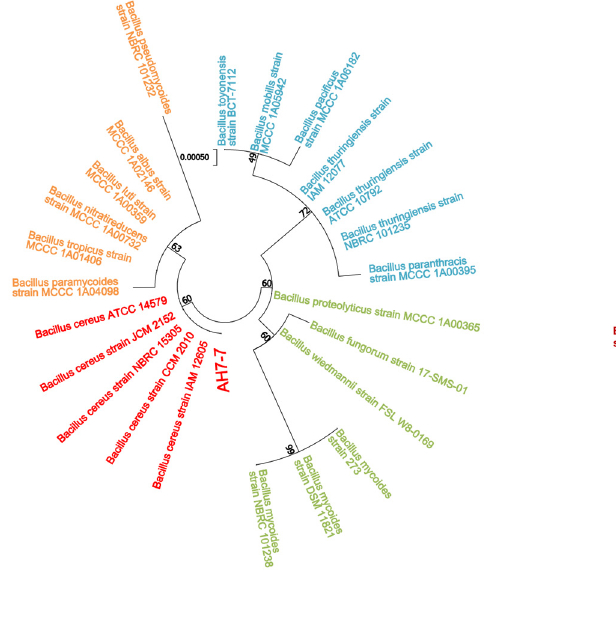
Figure 1. ( A ) Observation of colonies from strain AH7-7. ( B ) Gram staining of strain AH7-7 under the microscope (magnification 1000×, Olympus BX53).